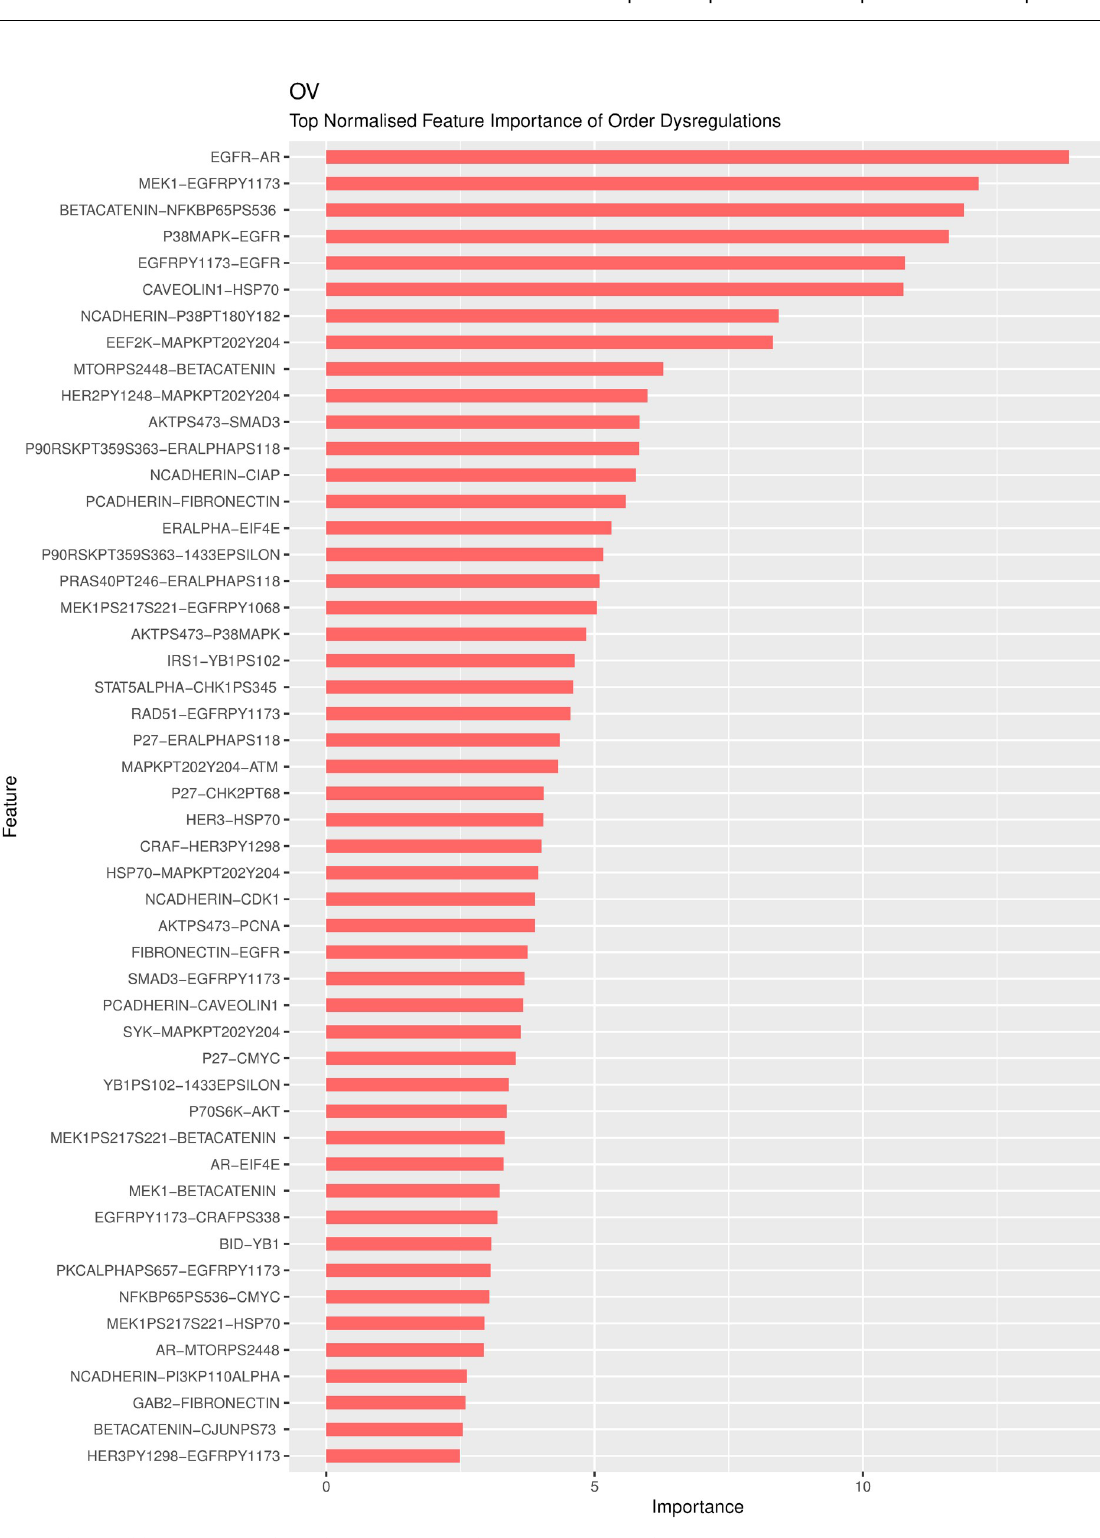
PLOS Computational Biology | https://doi.org/10.1371/journal.pcbi.1008998 May 26,